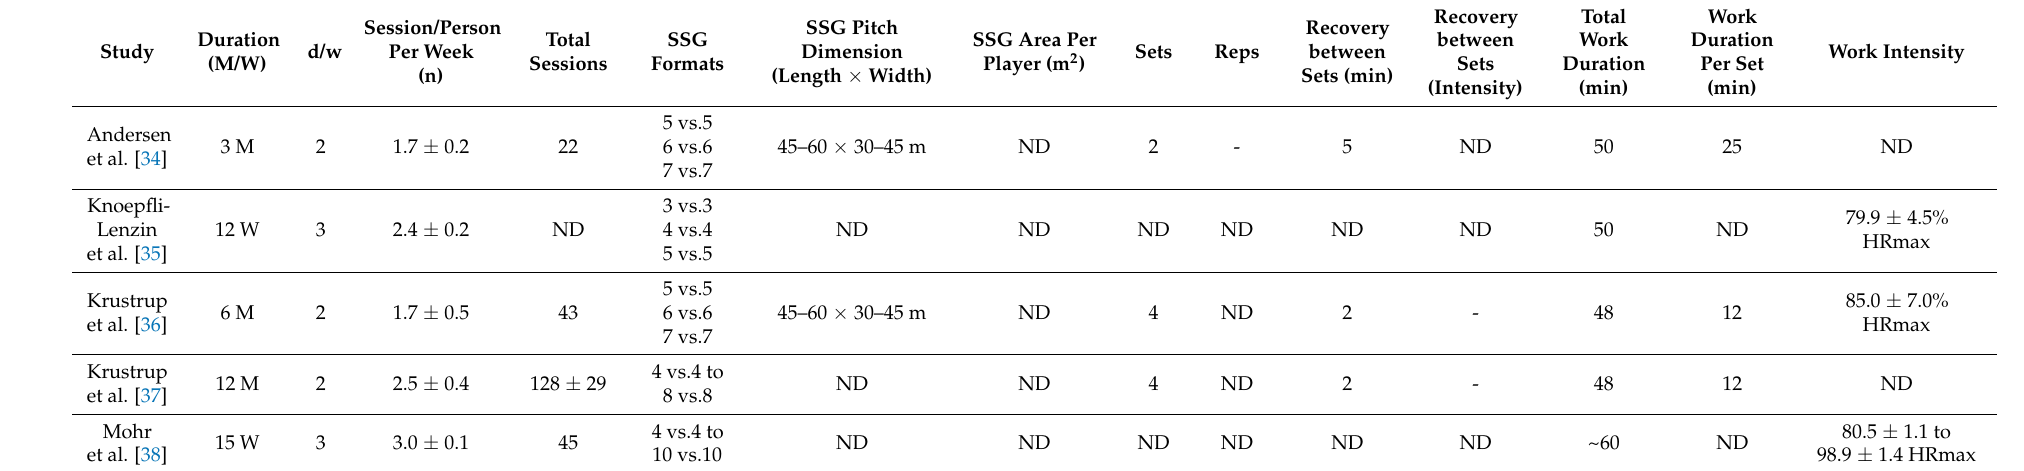
Table 3. Characteristics of SSG-based programs in the included